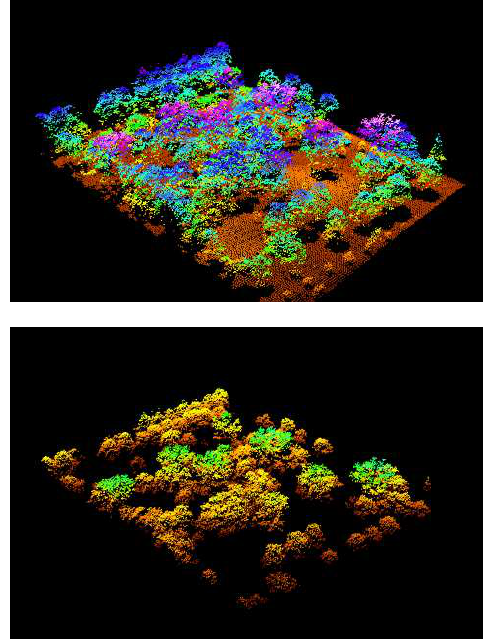
Figure 5. Visualization of the point cloud at different heights can facilitate the comprehension of the